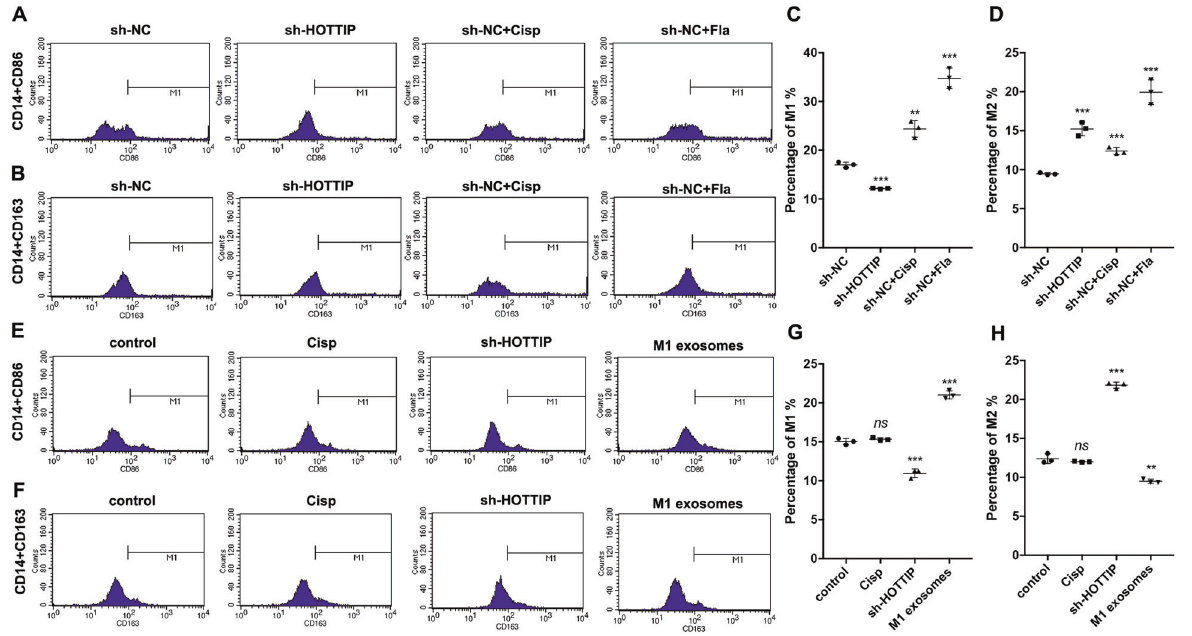
Fig. 7 Cancer cells expressing HOTTIP and M1 exosomes reprogram the circulating monocytes into M1 phenotype. A – D Flow cytometry assay detected CD14 + CD86 + M1 and CD14 + CD163 + M2 phenotype in circulating blood of nude mice bearing with HOTTIP-knockdown Hep-2 cells ( n = 3). HOTTIP-knockdown Hep-2 cells suppressed the polarization of M1 monocytes ( A , C ) but induced the polarization of M2 ( B , D ). E – H Flow cytometry assay detected M1 and M2 phenotypes in the blood of tumor-bearing nude mice treated by M1 exosomes ( n = 3). M1 exosomes induced the polarization of M1 monocytes ( E , G ) but inhibited the polarization of M2 ( F , H ). Data are presented as mean ± SD. Results were analyzed by One-way ANOVA with a post hoc test. Signi fi cance: ns not signi fi cant, ** P < 0.01, *** P <